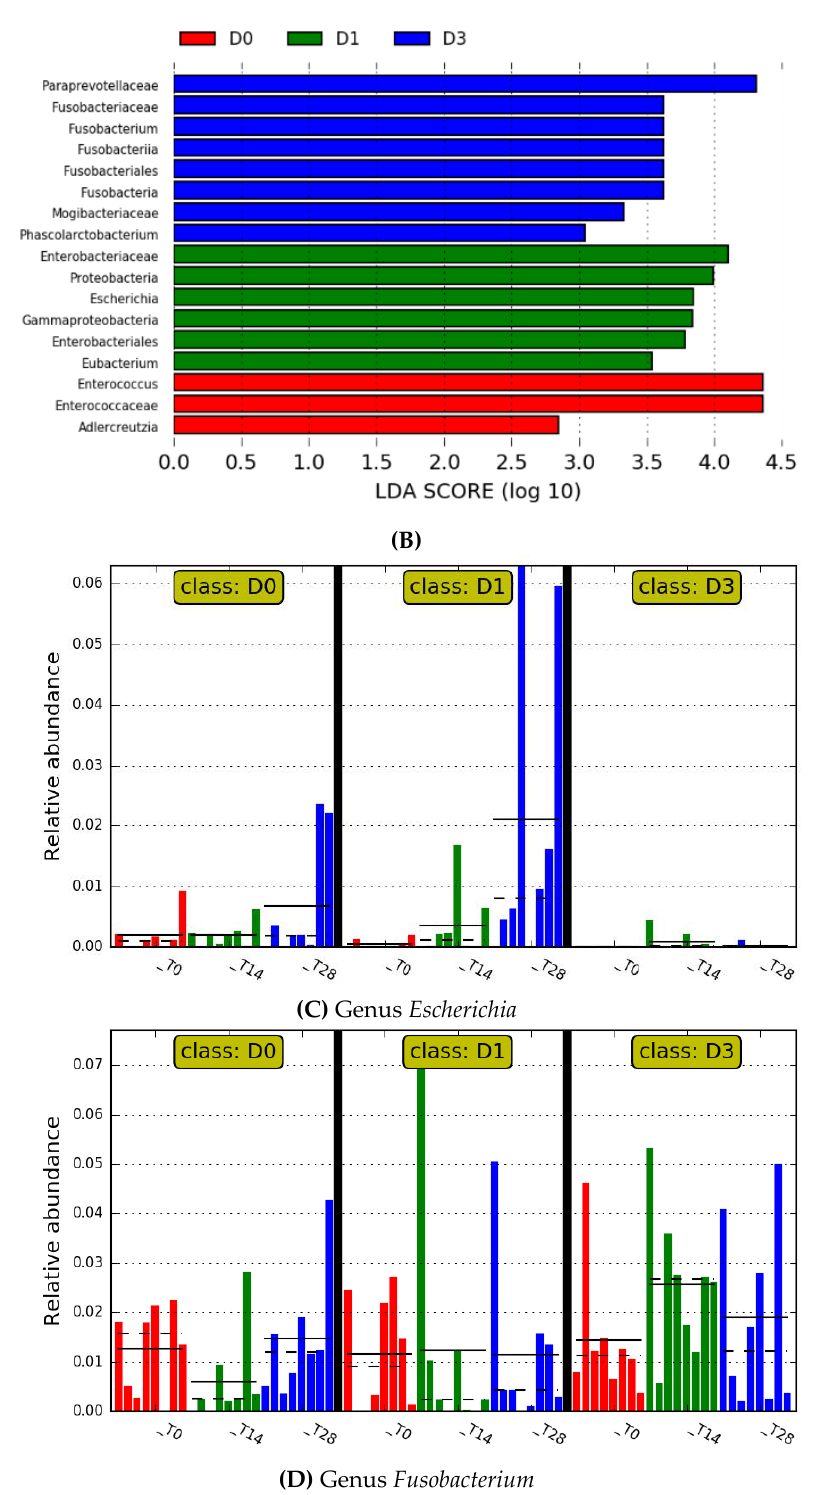
Figure 3. Bacterial taxa differentially abundant in the feces of the dogs without administration of proanthocyanidins (D0), receiving a supplementation of 1 mg/kg live weight (D1) or 3 mg/kg live weight (D3) of proanthocyanidins. The cladogram in (A) highlights impactful communities within each treatment and (B) shows the score of the linear discriminant analysis (LDA, significant threshold > 2). (C) and (D) show the individual data for two of significant genera, where dotted line denotes the median and solid line the mean of each subgroup.